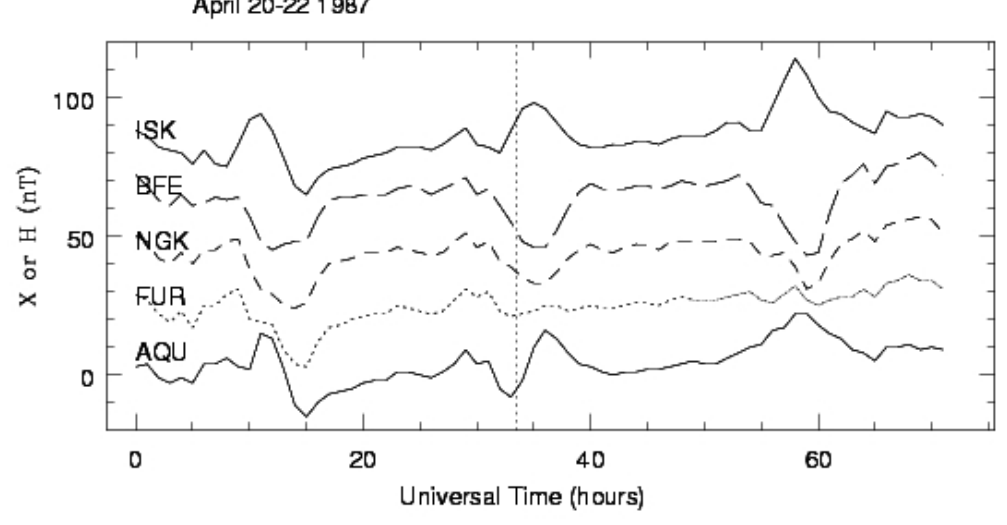
Fig. 13. Magnetic variations in X or H , plotted hourly, at five stations in Europe from 20 to 22 April 1987. The vertical dashed line represents Fig 13.Magnetic variations in X or H, plotted hourly, at five stations in Europe from April 20 to 22, the time of the focus at AQU on 21 1987. The vertical dashed line represents the time of the focus at AQU on April 21.